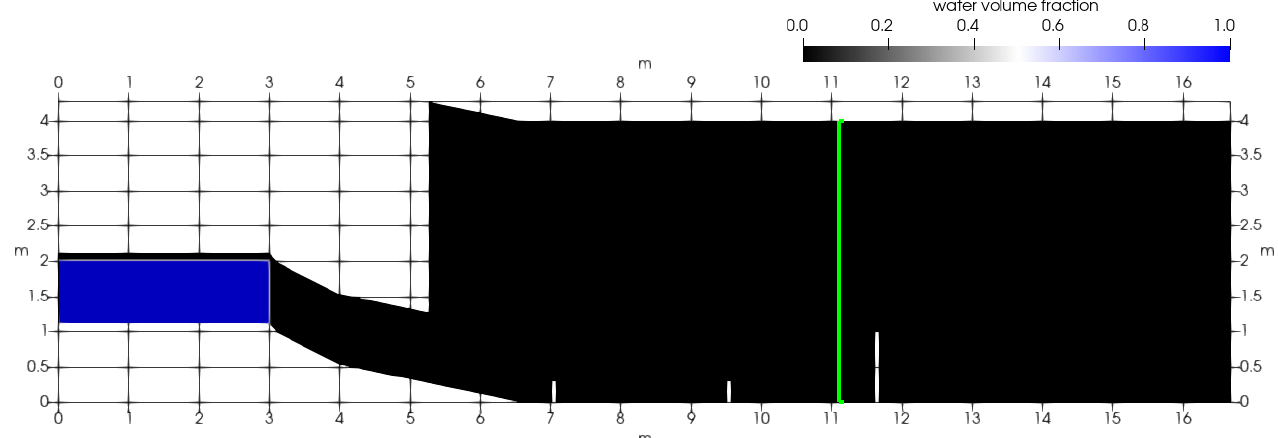
Figure 2. Calculation domain and initial condition for simulating the experiment at the University of Iceland experiment chute. The green line shows the location of the section in which the data was measured and calculated for the flow without dams.